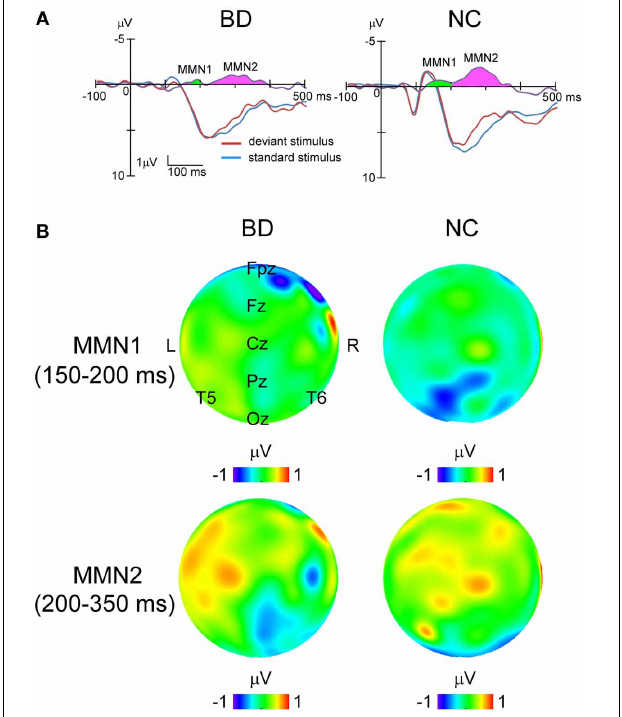
FIGURE 2 | Grand averaged waveforms to standard and deviant stimuli at Oz and topographical maps of MMNs in each group. (A) Blue lines , standard stimuli. Red lines , deviant stimuli. Purple lines , their difference waveforms. Green area , MMN1. Pink area , MMN2. (B) Topographical maps of potential in MMN1 and MMN2 for each group. The upper panel shows that MMN1 distributes around Pz area, while the lower panel demonstrates that MMN2 spread over the right occipitotemporal